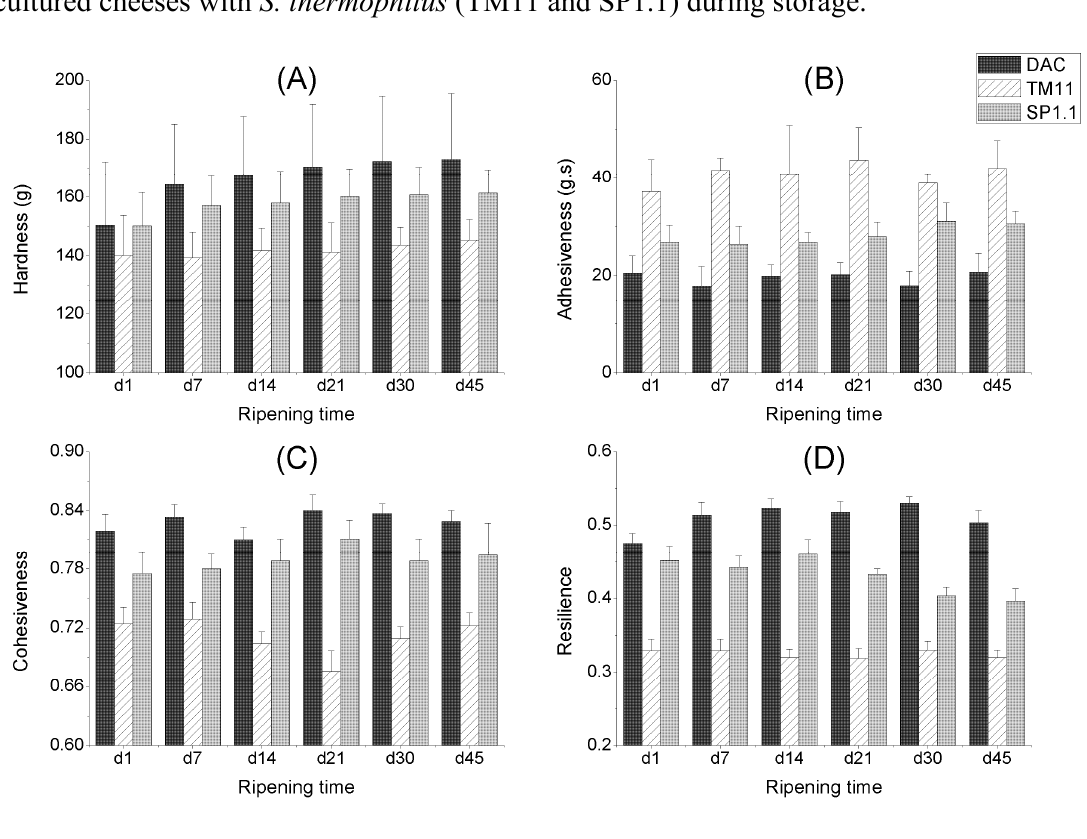
Figure 2. Changes in textural properties of the direct-acidified cheese (DAC) and the cultured cheeses with S. thermophilus (TM11 and SP1.1) during